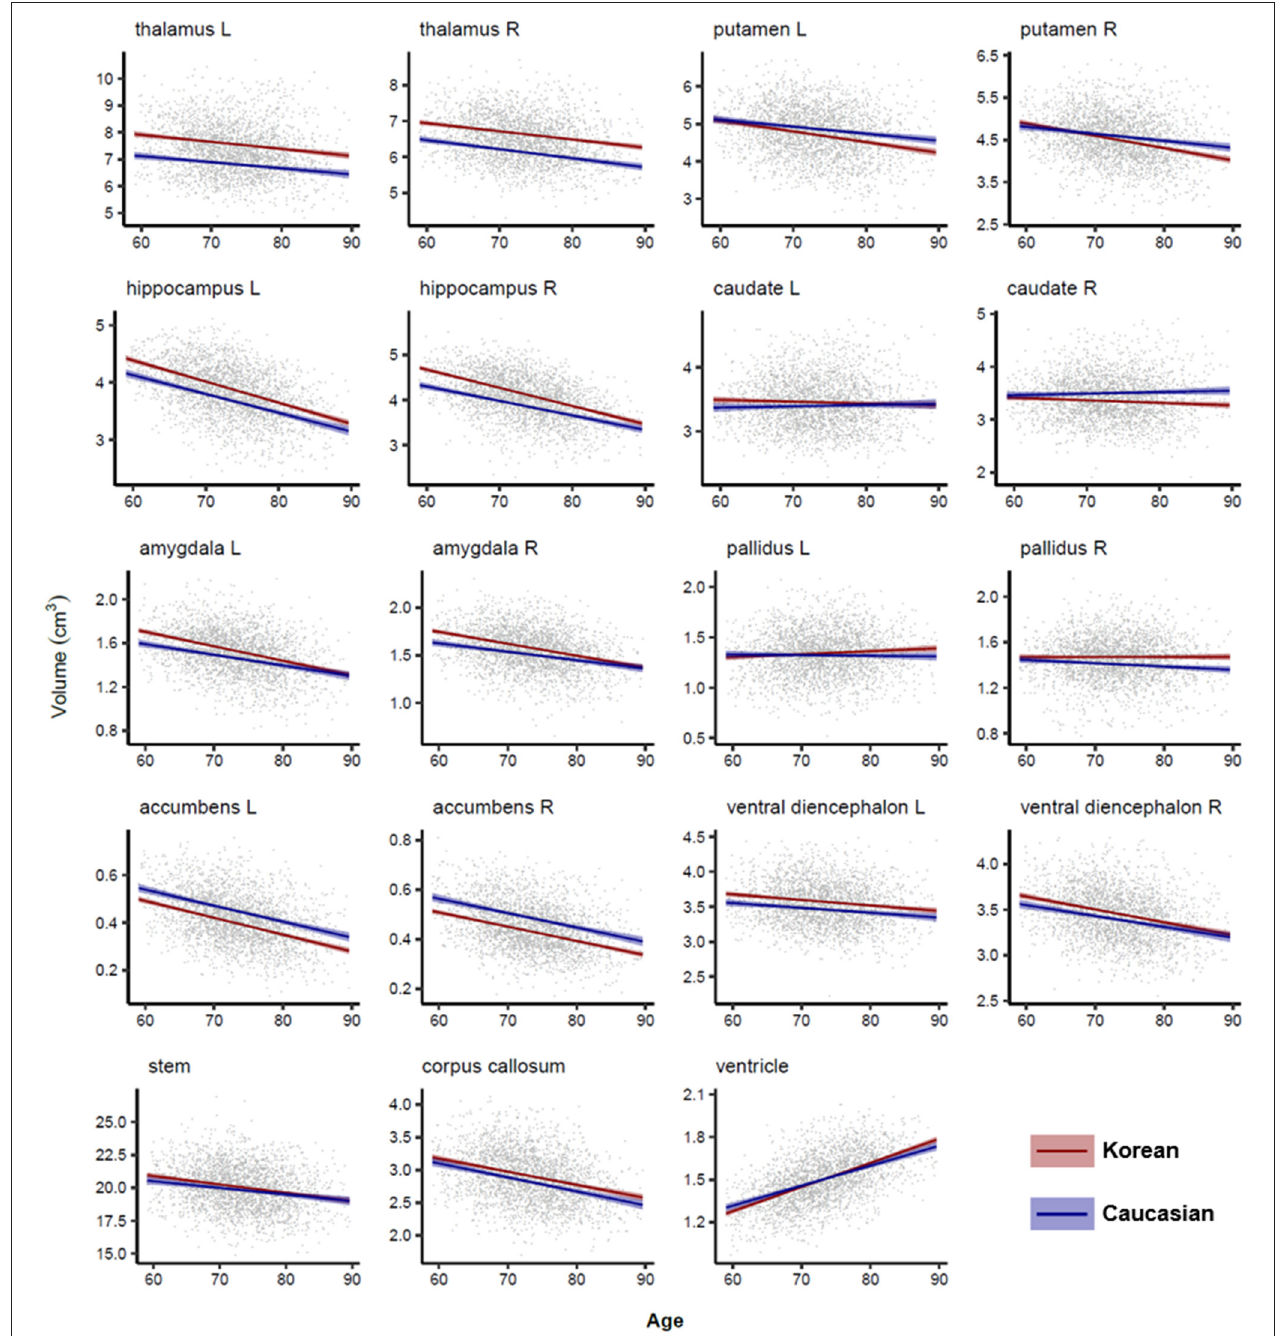
FIGURE 5 | Subcortical volume changes with age in Caucasian and Korean elderly peoples. This figure illustrates ethnic contrast in age effect in each model predicting subcortical volumes in a massive sample of cognitively normal people aged 59–89 years. Each line denotes mean volume with 95% confidence intervals in the colored shade. Ventricular volumes are log 10 transformed.